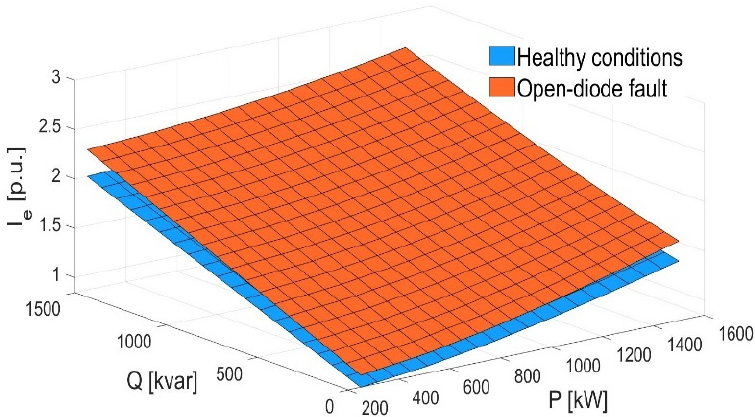
Figure 5. Simulation results. I e (p.u.) represented for different (P, Q) operating setpoints at reference voltage for F1: open-diode fault.